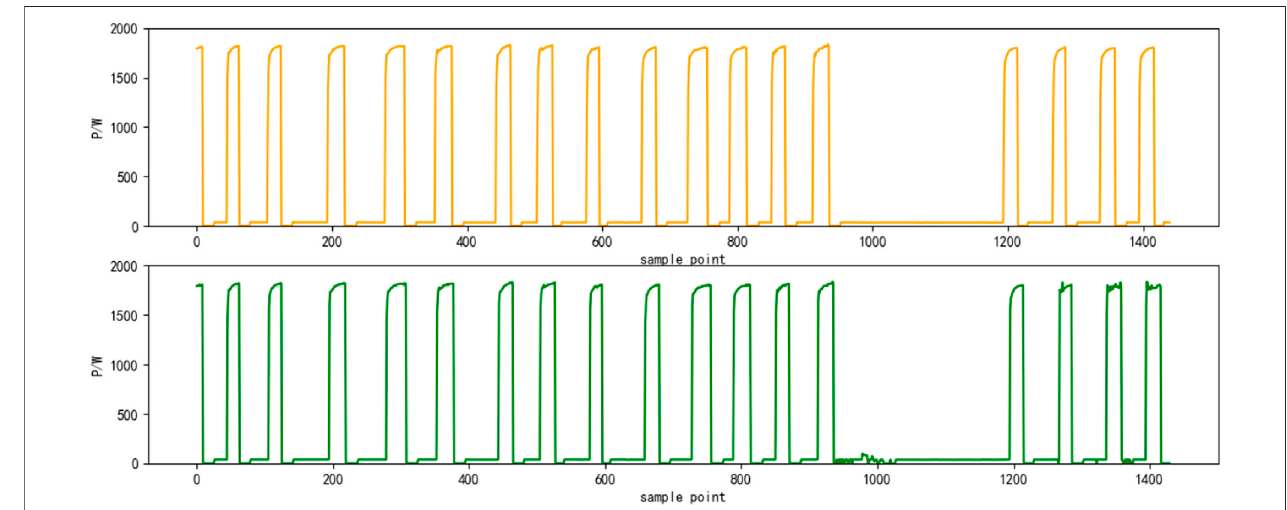
FIGURE 4 | Results of power decomposition (HPE).